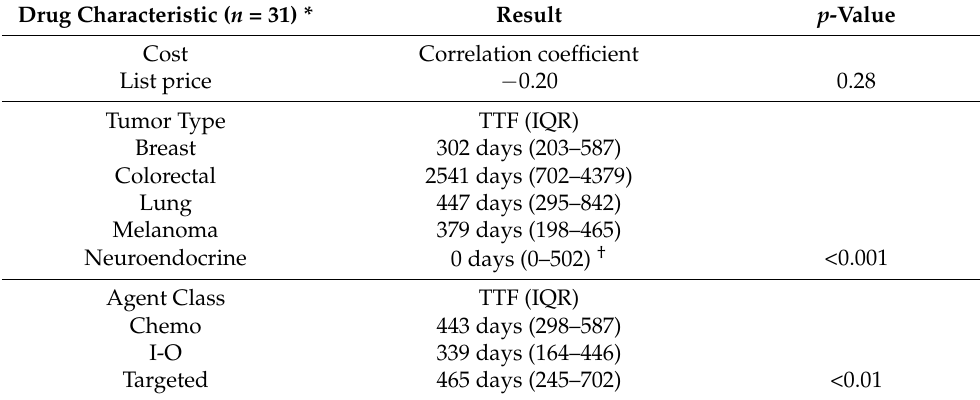
Figure 1. Scatter plot of time-to-funding by cost per 28-day course. Table 3. Time to funding based on drug characteristics.